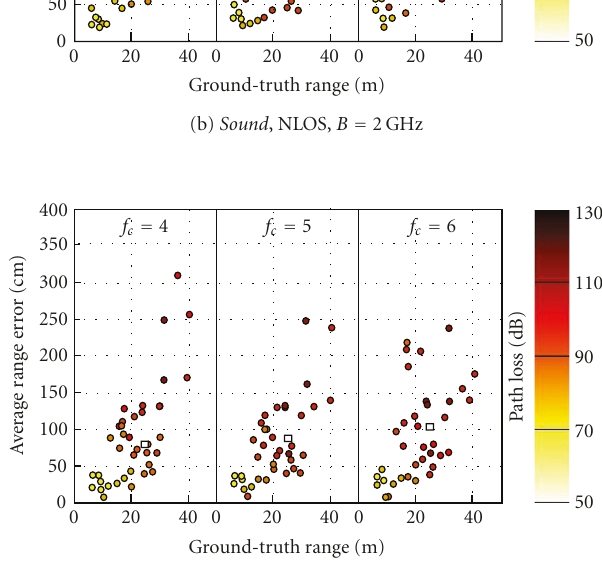
0.5 GHz to 4 GHz, but at a diminishing rate, and shows vir- tually no further improvement at 6 GHz. The error increases up to 31 cm from a center frequency of 3 to 7 GHz due to larger path loss of the latter with an obstructed direct path, but remains fairly constant in line-of-sight